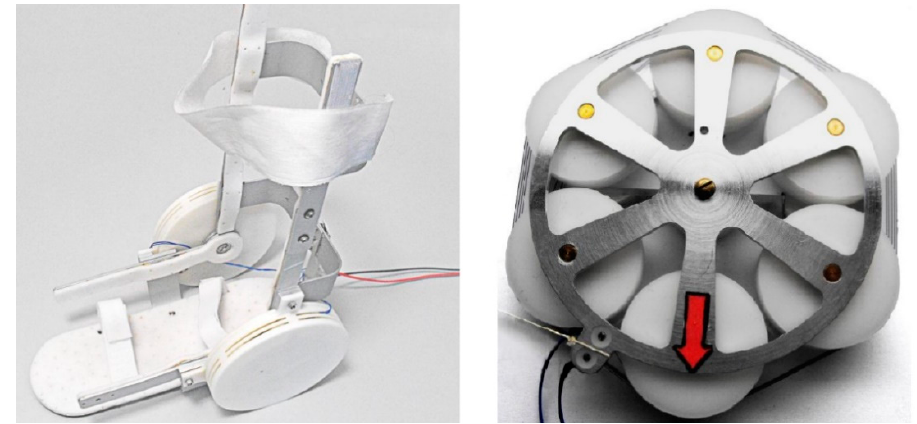
Figure 34. The application of a rotary SMA actuator in an AFO (in the left) as well as rotary SMA actuator (in the right) [60].